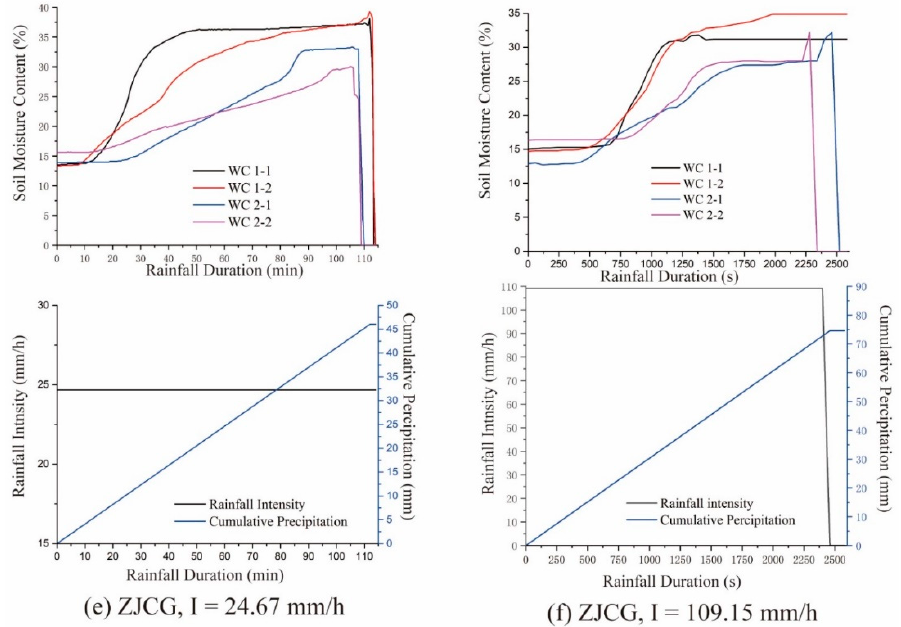
Figure 16. Variation curve of volumetric water content under different gradation and rainfall con- ditions.